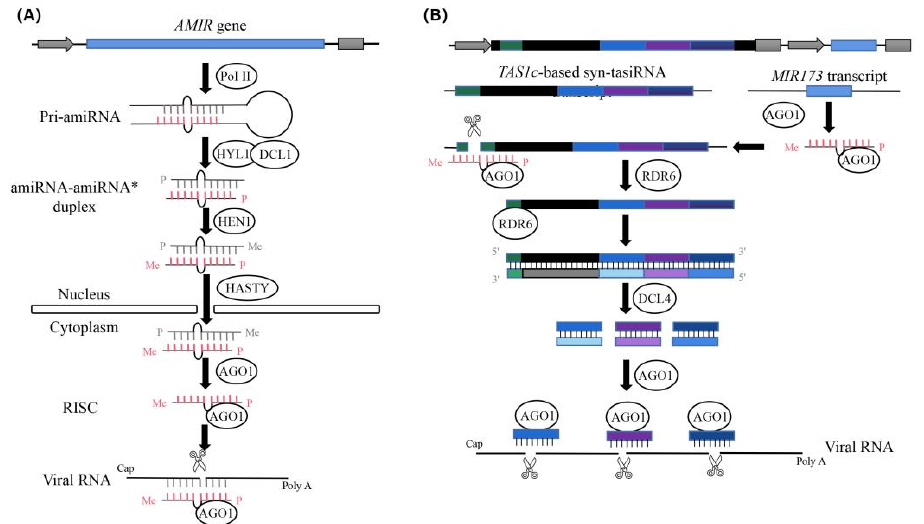
Figure 1. The diagram of the process of antivirus artificial microRNA (amiRNA) and synthetic trans ‐ acting small interfer ‐ ing RNA (syn ‐ tasiRNA) production (revised from Jones ‐ Rhoades et al. and Carbonell et al.). ( A ) Diagram of the biogenesis and activities of artificial microRNA (amiRNA) products. Pri ‐ amiRNAs are transcribed by RNA polymerase II(Pol II). The amiRNA ‐ amiRNA* duplex produced by DCL1 is then exported to the cytoplasm, possibly through the action of the plant exportin 5 ortholog HASTY. The guide amiRNA strand is then incorporated into AGO proteins to carry out the silencing reactions. ( B ) Diagram of the biogenesis and activities of synthetic trans ‐ acting small interfering RNA (syn ‐ tasiRNA) prod ‐ ucts. Three different antivirus syn ‐ tasiRNAs (in light or dark blue or purple boxes) were inserted into the TAS1c gene from Arabidopsis thaliana (in black). The miR173 target site (TS) is shown with a green square box. A cassette, including the A. thaliana MIR173 precursor (in blue) to generate miR173, was inserted downstream of the syn ‐ tasiRNA cassette. Specific cleavage sites in target sites located in viral RNAs are indicated with black arrows, with TS coordinates indicated in brack ‐ ets.